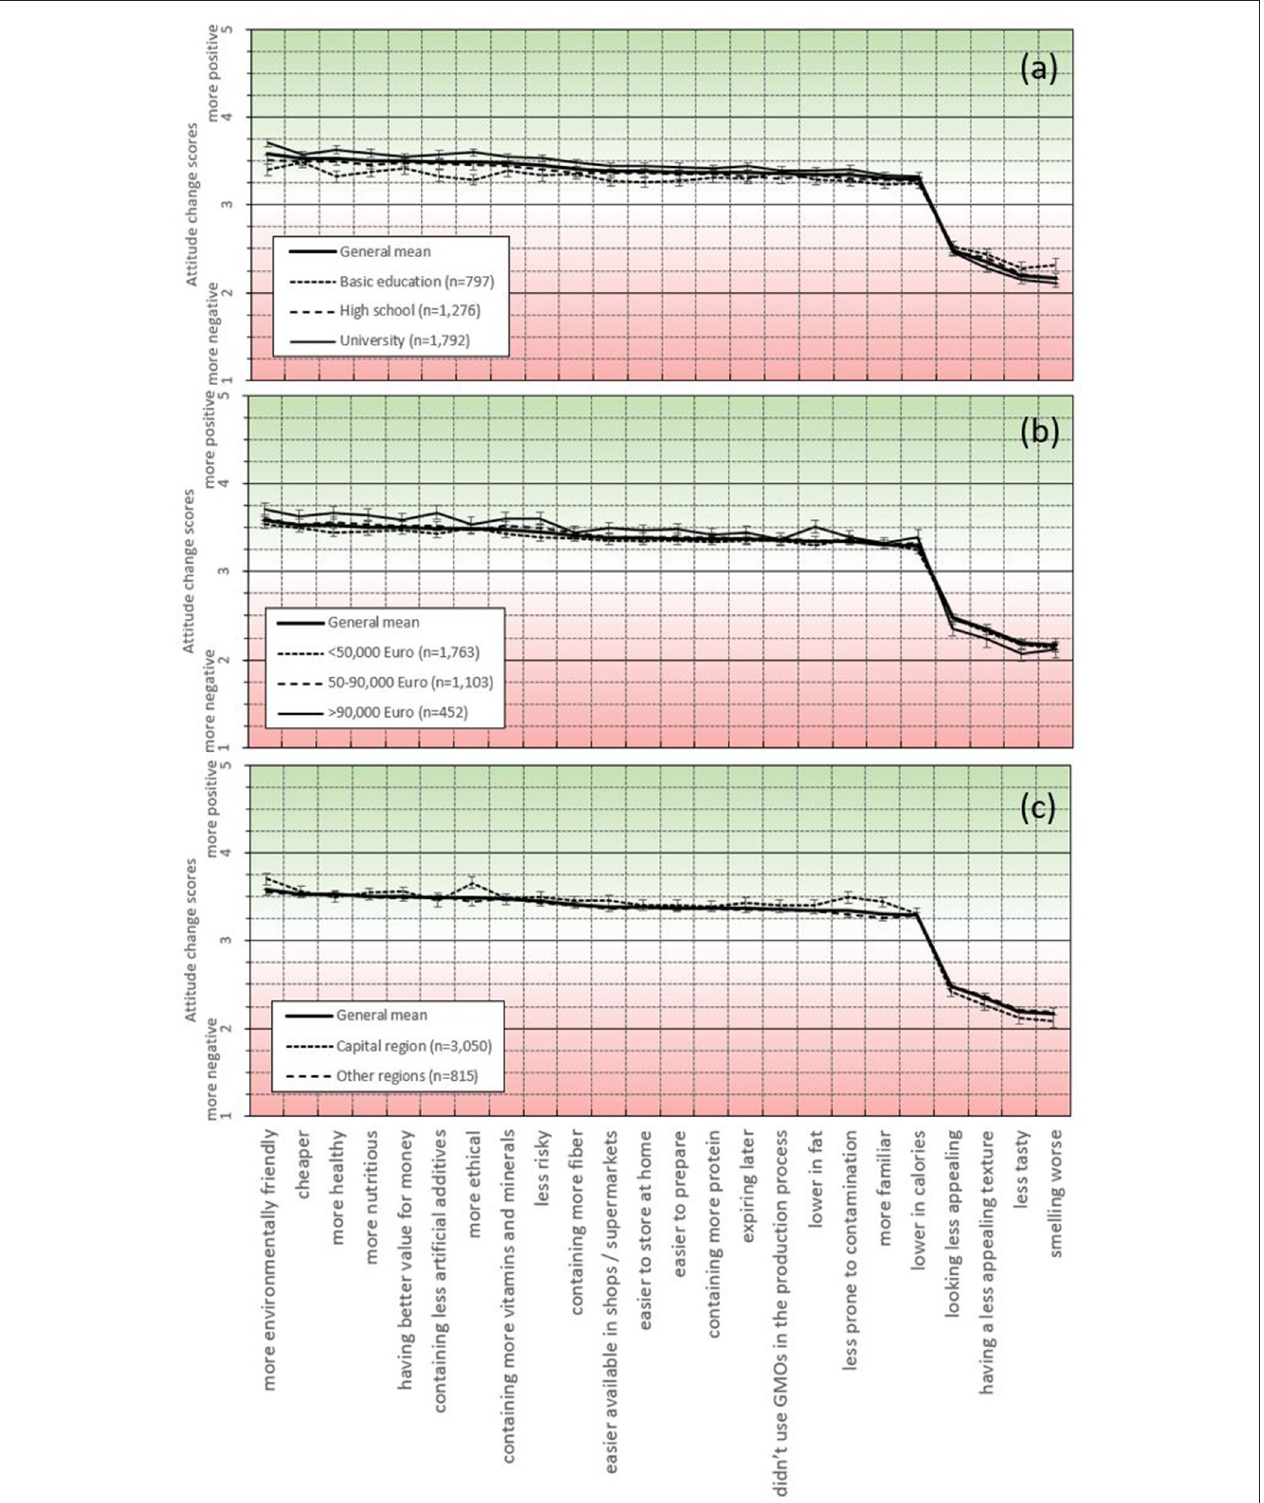
FIGURE 5 | Differences between education (a) , income (b) , and the capital vs. other regions (c) . The error bars represent 95% credibility intervals estimated with Bayesian estimation.